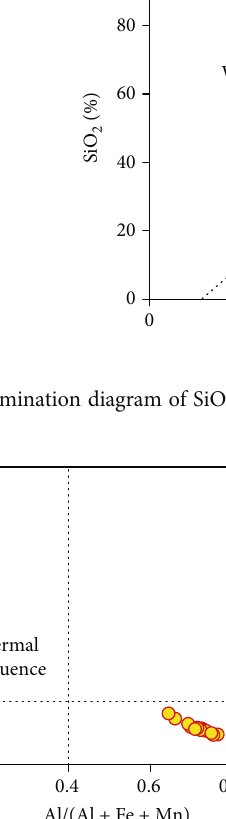
0.0 Figure 11: Discrimination diagram of ð Fe + Mn Þ /Ti versus Al/ ð Al + Fe + Mn Þ for the in fl uence of hydrothermal activity [60] in the Chang 7 3 black